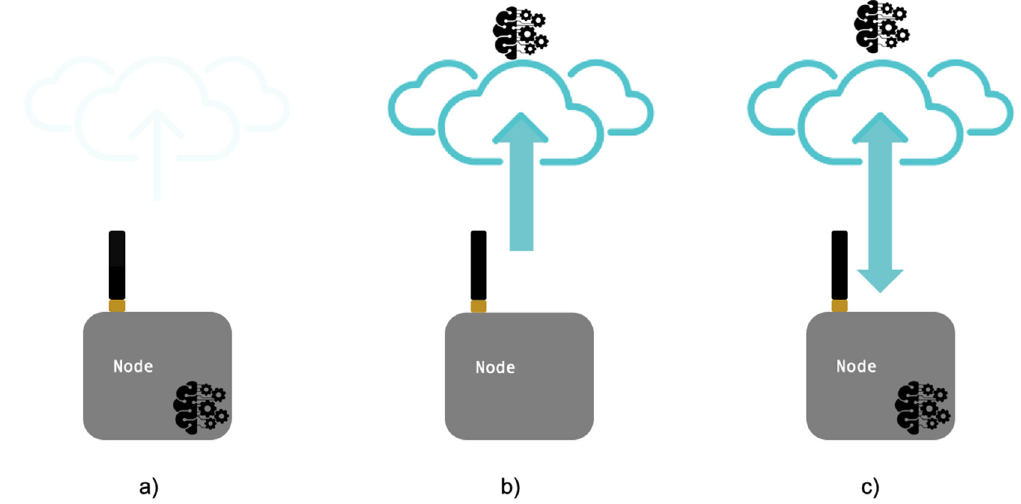
Figure 4. ( a ) On ‐ device computation, ( b ) edge server ‐ based architectures, and ( c ) joint computation. Figure 4. ( a ) On-device computation, ( b ) edge server-based architectures, and ( c ) joint